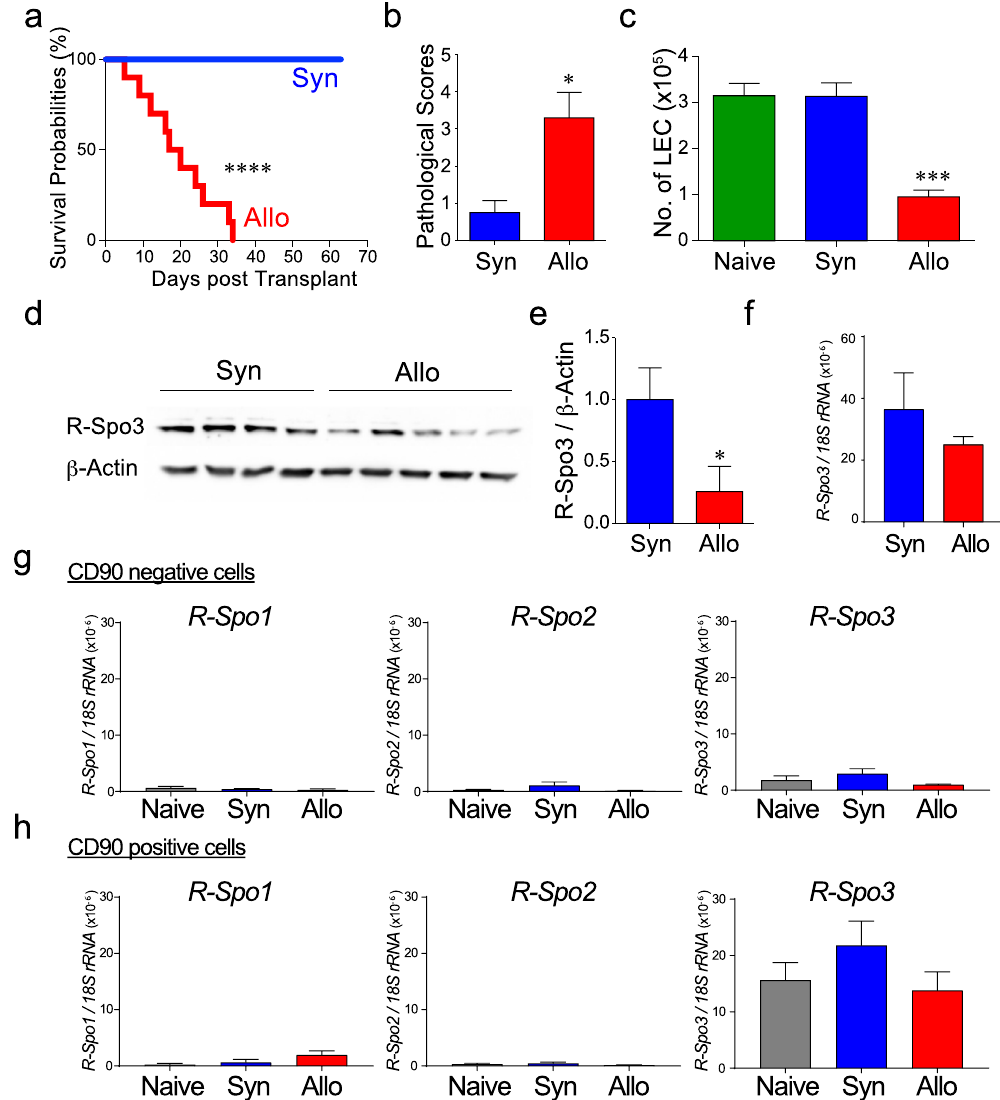
Figure 5. R-Spo3-producing LECs are reduced in acute GVHD. B6D2F1 mice conditioned with busulfan and cyclophosphamide were transplanted with bone marrow cells and splenocytes from allogeneic C57BL/6 (Allo) or syngeneic B6D2F1 (Syn) donors. ( a ) The survival probabilities of the recipients (n = 10/group). ( b – f ) The small intestines were harvested on day + 14 after transplantation. ( b ) Pathological scores of the small intestines from Syn (n = 4) and Allo mice (n = 6) are shown. ( c ) The absolute numbers of LECs in the small intestine were evaluated by flow cytometric analysis (Naïve; n = 10, Syn; n = 12, Allo; n = 13). ( d , e ) R-Spo3 protein in small intestinal lysates was detected by western blotting ( d ), and relative concentrations of R-Spo3 to those of β -actin in the small intestines are shown ( e ). ( f ) Expression levels of R-Spo3 in LECs from Syn (n = 4) or Allo (n = 5) recipients were measured by quantitative PCR. ( g , h ) Expression levels of R-Spos in CD45 − CD90 − cells ( g ) and CD45 − CD90 + cells ( h ) were measured by quantitative PCR (n = 4/group). ( a , c , e ) Data from two similar experiments were combined. ( b , f – h ) Representative results from one of two independent experiments with similar results are shown. Data are shown as the means ±